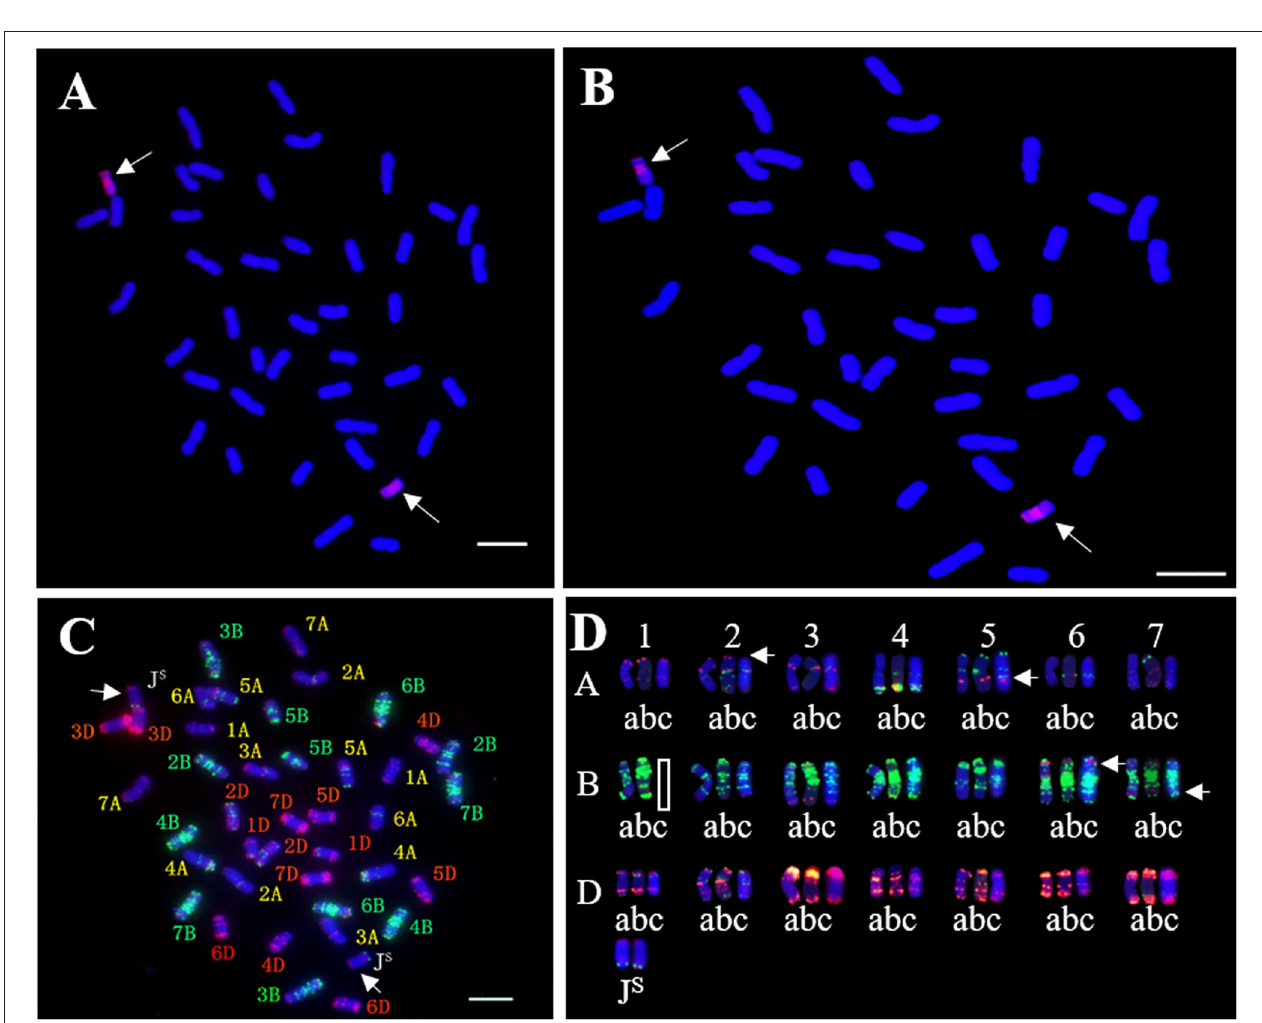
FIGURE 2 | In situ hybridization analysis of SN19647. (A) GISH pattern of SN19647 probed with Th. ponticum genomic DNA. (B) GISH pattern of SN19647 probed with Ps. spicata genomic DNA. (C) FISH pattern of SN19647. (D) Comparison of wheat chromosomes in SNTE20 (a), JM22 (b) and SN19647 (c). Arrows indicate the chromosomes J S or locations with different FISH bands. Scale bars = 10 µ